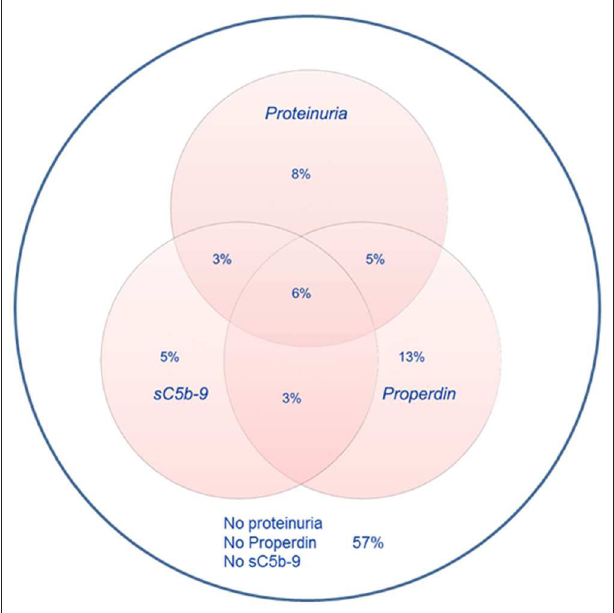
FIGURE 1 | Prevalences of urinary properdin, urinary sC5b-9, and